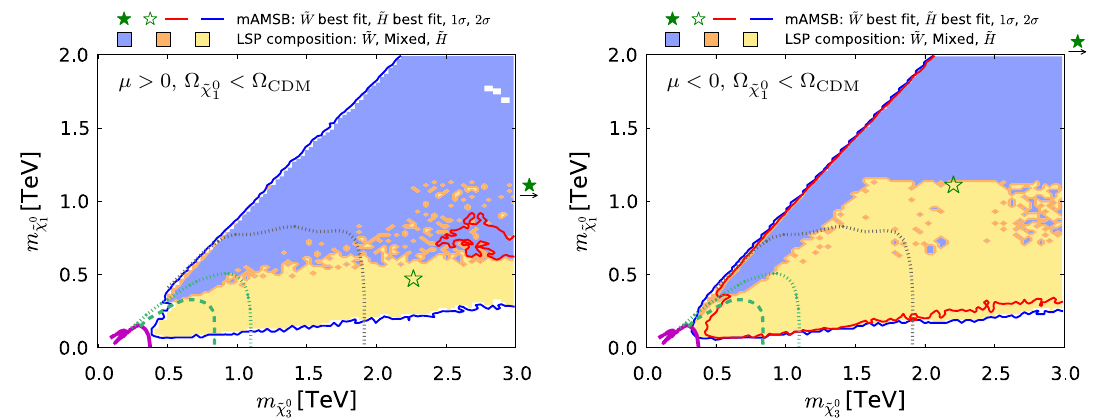
, m ) plane allowed in the (cid:4) ≤ line shows the projected sensitivity for 14-TeV data with an integrated Fig. 24 The region of the ( m ˜ χ 0 ˜ χ 0 ˜ χ 0 3 1 1 μ > 0 ( left ) and μ < 0 ( right ). The purple solid line (cid:4) luminosity of 300 f b − 1 (3000 f b − 1 ) estimated by ATLAS [141]. The CDM case for grey dotted line is the 95% CL sensitivity expected at a 100 TeV pp represents the CMS 13-TeV 95% CL exclusion [143] assuming a sim- collider with a 3000 f b − 1 integrated luminosity obtained from [144]. plified model with wino-like chargino and neutralino production and The shadings are the same as in Fig. 4 100% BR for the W ± Z + / E T final state. The green dashed (dotted)